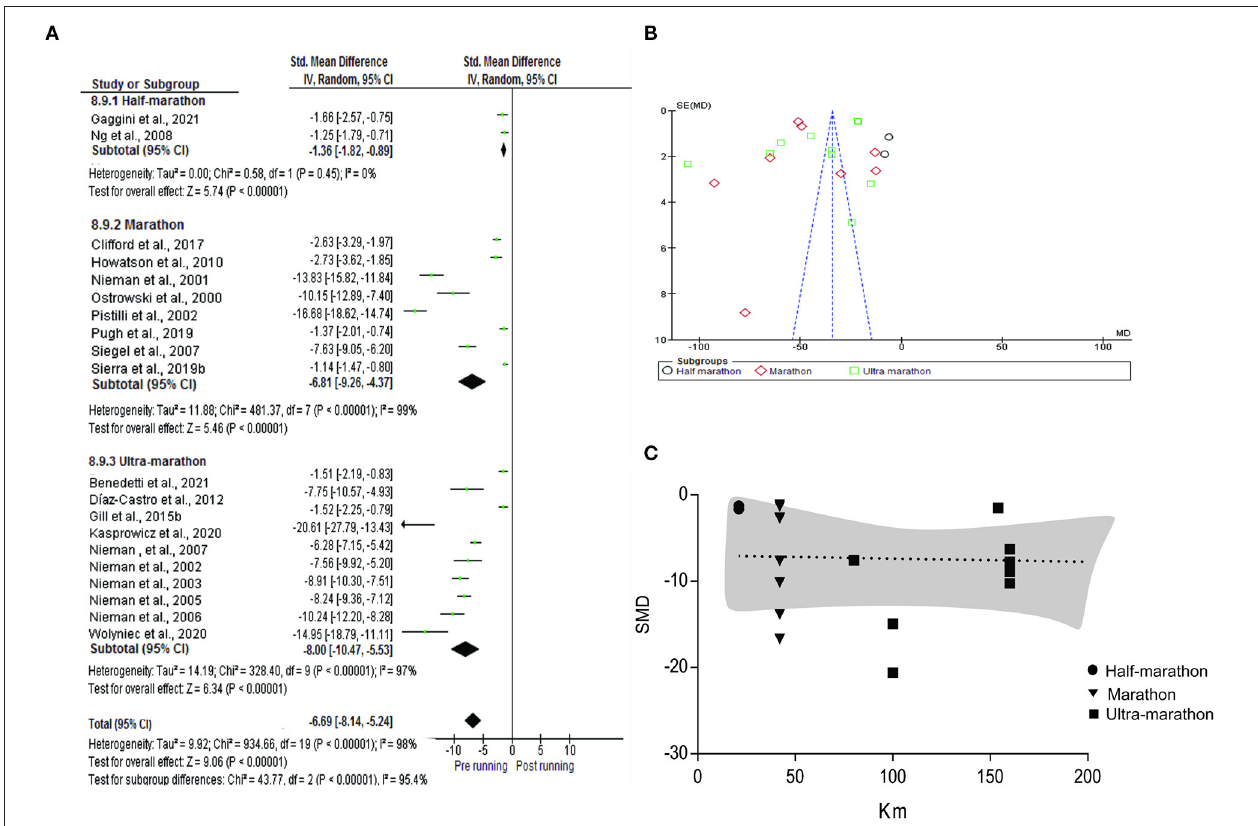
FIGURE 4 | Meta-analysis of half-marathon, marathon, and ultra-marathon. (A) Forest plot, (B) Funnel plot, and (C) meta-regression